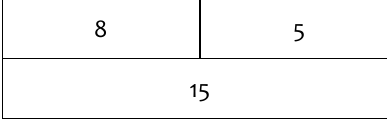
Figure 3: Sam’s solution to the 8 – 15 part-whole